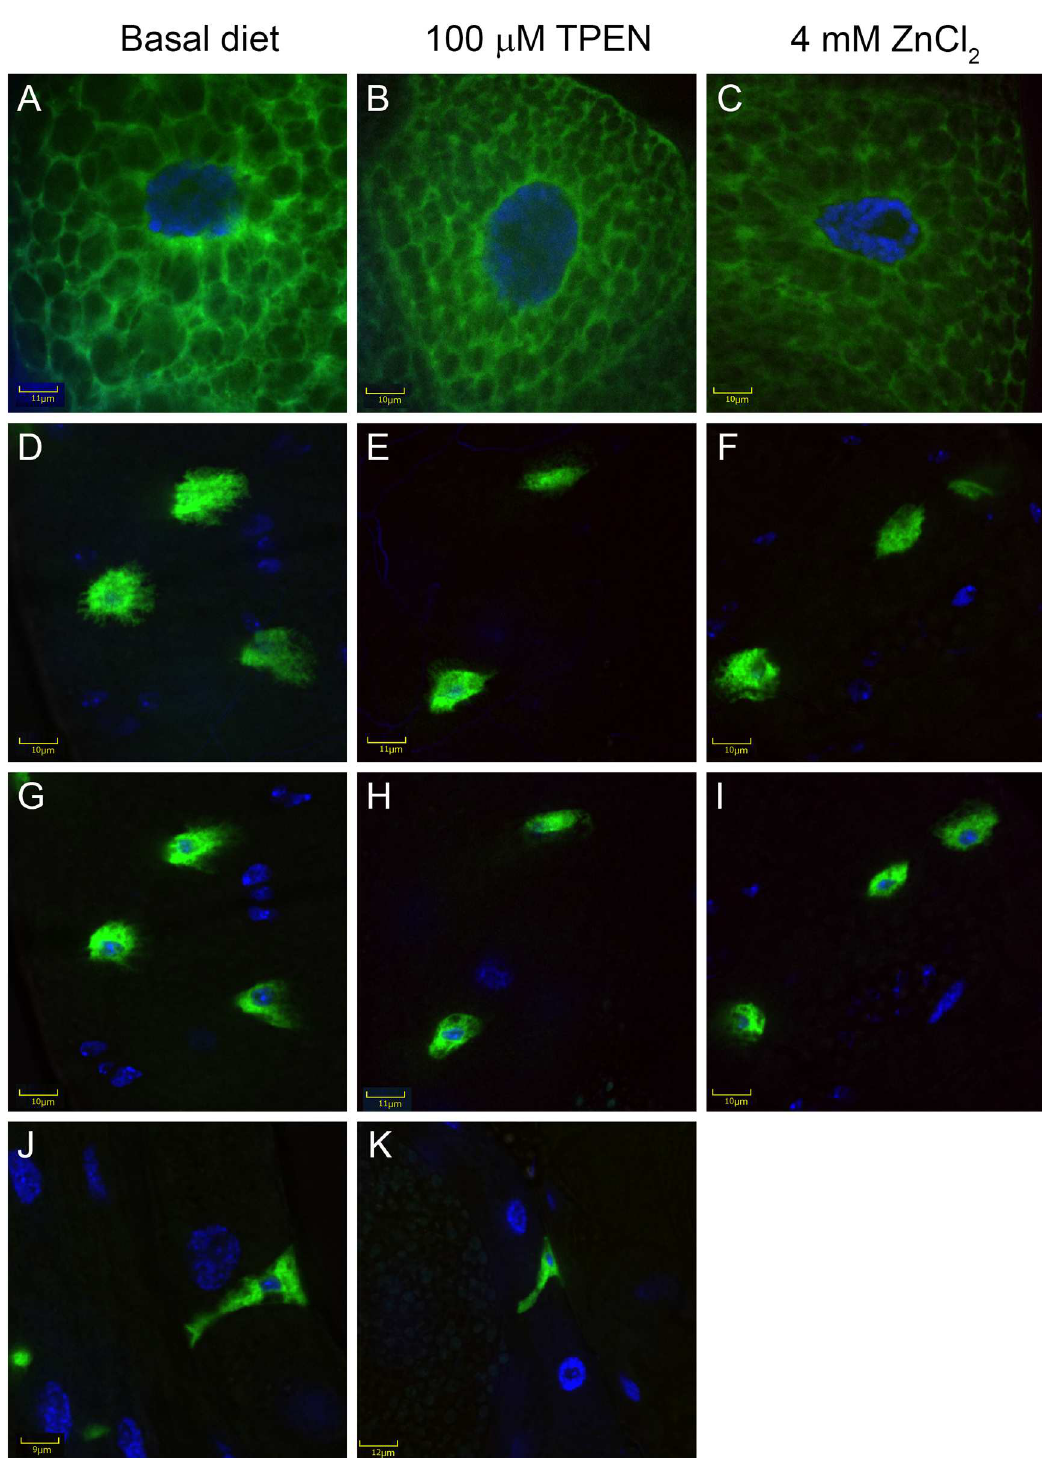
Fig 6. Zip88E protein localisation is not affected by altered zinc dietary content. Confocalmicroscopy showing salivary gland cells (A-C) and midgut enteroendocrine cells (D-K) with Zip88E-GAL4 > Zip88E::eGFP (green)and nuclear DAPI staining (blue) from third instar larvae raised on basal media (A, D, G, J) or media supplemented with 100 μ mol l -1 TPEN (low zinc, B, E, H, K) or 4 mmol l -1 ZnCl 2 (high zinc, C, F, I). In the enteroendocrinecells, Zip88E::eGFP is observed at both the outer cell surface (D-F) and surrounding the nucleuswithin the body of the cell (G-I). A lateral view of these cells (J, K) illustrateshow they span the width of the midgut epitheliallayer.